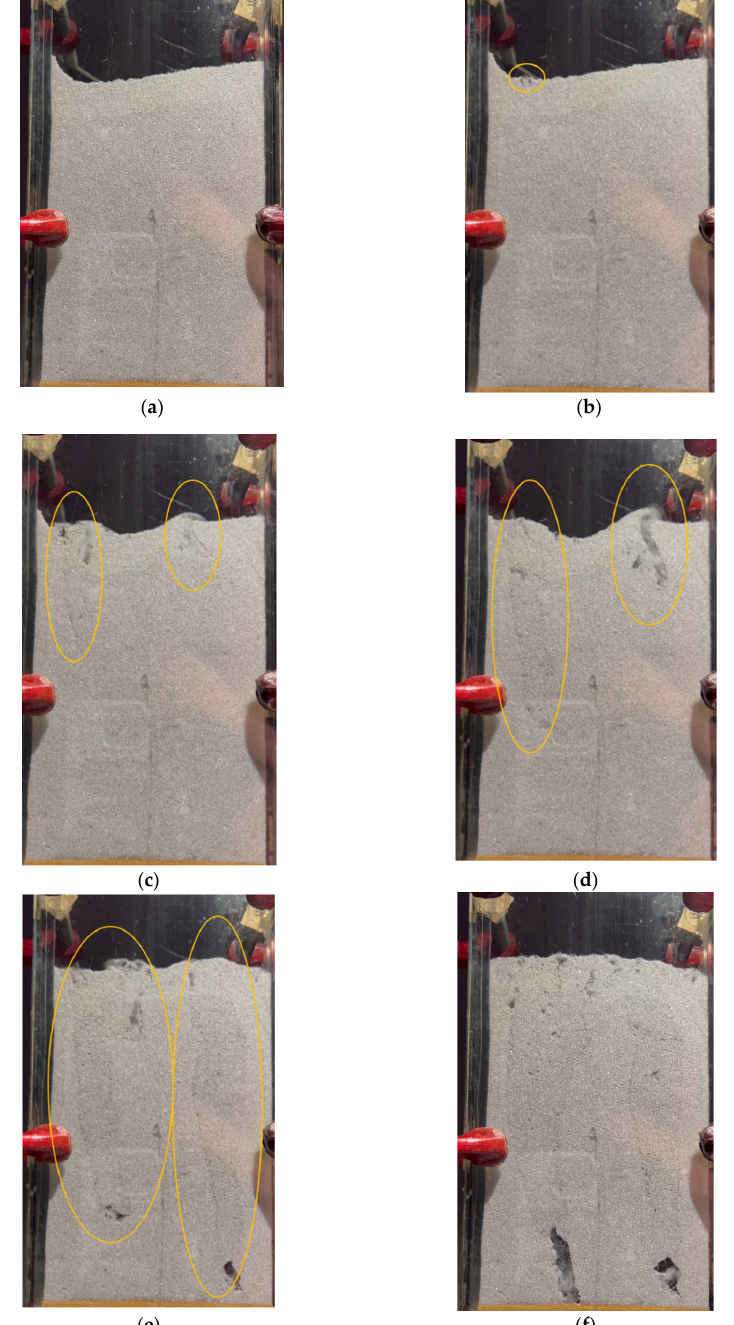
Figure 7. Gas flow through friable material (glass balls): gas flow through homogeneous material without change to its structure ( a ); formation of low-density zones propagating toward the cell bottom ( b – e ); propagation of the low-density wave toward the cell bottom with loosening the whole ball mass ( f ).